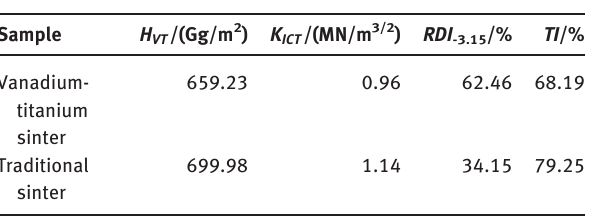
Table 5: Comprehensive hardness value and fracture toughness value of